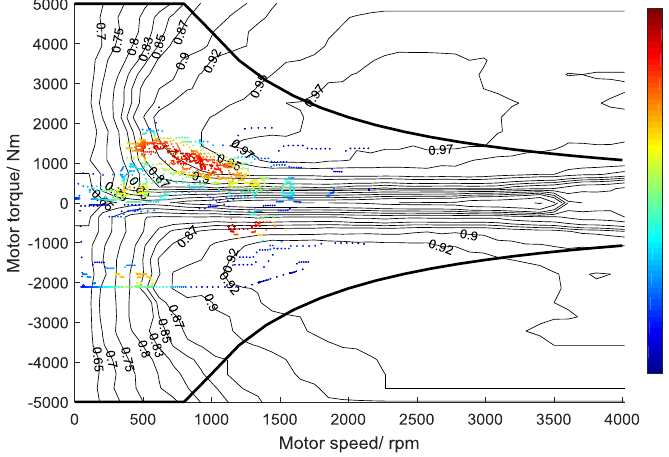
Figure 18. Operating point distribution on the motor efficiency map of the EDT with a two-speed transmission.